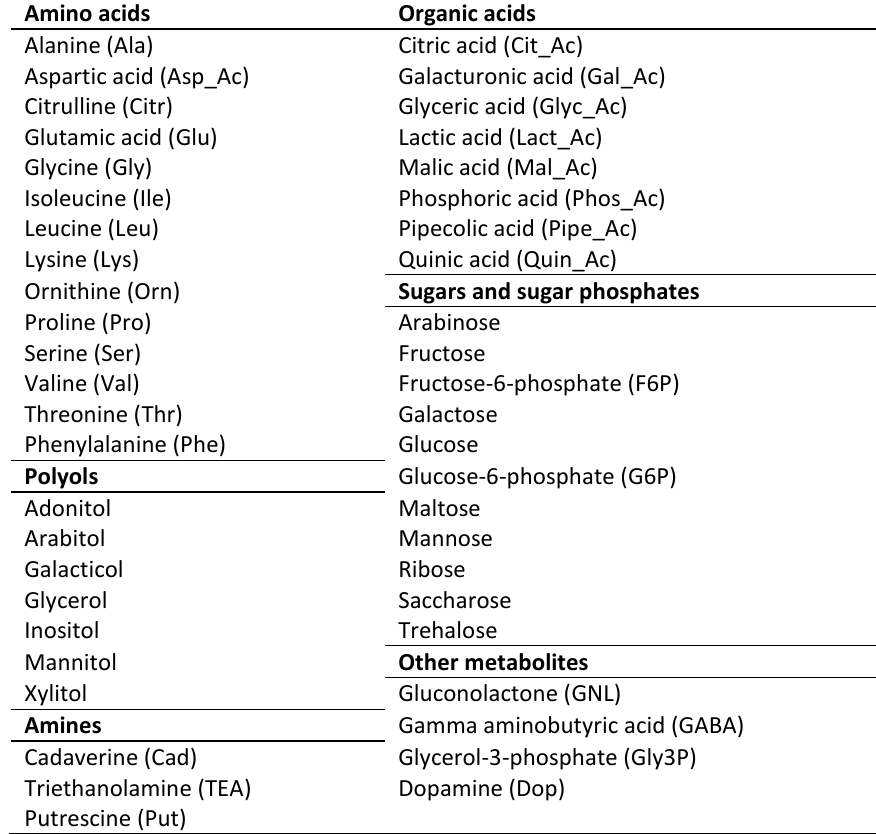
Table 1 : Metabolites detected in each of the two morphs (viviparous and oviparous females) of the pea aphid, Acyrthosiphon pisum . Each metabolite has been found in each morph. Abbreviations used on Figure 3 are in